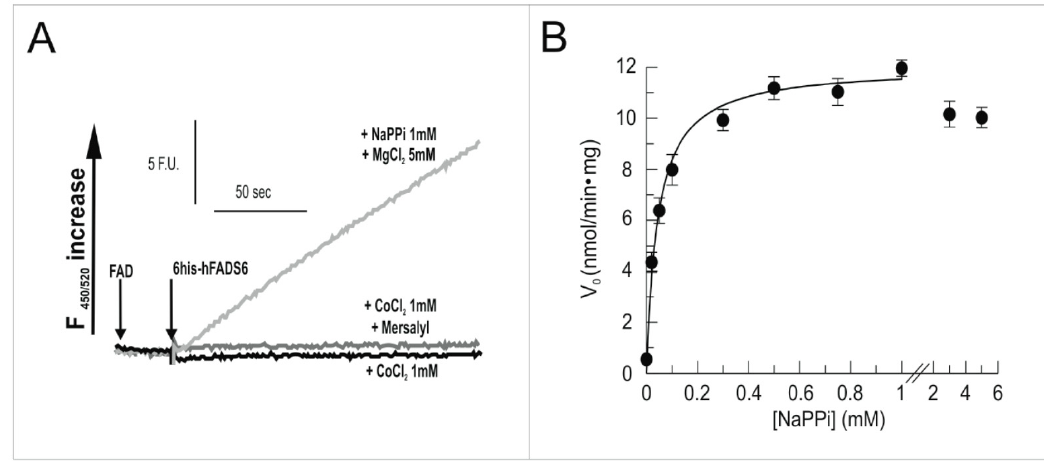
Figure 6. Fluorimetric evidence for FAD cleavage as catalyzed by 6-His–hFADS6. ( A ) Fluorimetric evidence of FAD cleavage. The reaction was measured in 50 mM Tris/HCl, pH 7.5, containing 0.5 µM FAD and 1 mM NaPPi, at 37 °C, in the presence of 5 mM MgCl 2 (light grey). The FAD cleavage reaction (i.e., pyrophosporolysis) was started by the addition of the 6-His-hFADS6 protein (0.13 µM) and was measured by the initial rate of fluorescence increase ( λ excitation = 450 nm, λ emission = 520 nm). FAD hydrolysis was measured under the same conditions, if not for omitting NaPPi and MgCl 2 , and in the presence of either 1 mM CoCl 2 (black line) or 1 mM CoCl 2 plus 0.5 mM Mersalyl (dark grey); ( B ) NaPPi concentration dependence. FAD cleavage (i.e., pyrophosporolysis) rate, catalyzed by purified 6-His–hFADS6 (0.13 µM), was measured fluorimetrically at 37 °C in 2 mL of 50 mM Tris/HCl pH 7.5, in the presence of 5 mM MgCl 2 , 0.5 µM FAD, and of the given NaPPi concentrations.